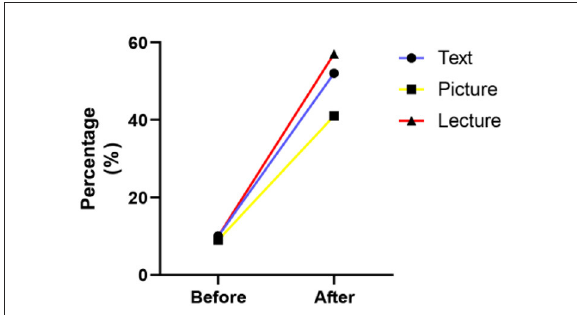
FIGURE1 The percentage of participants willing to donate biospecimen before and after text-, picture- and lecture-based publicity.